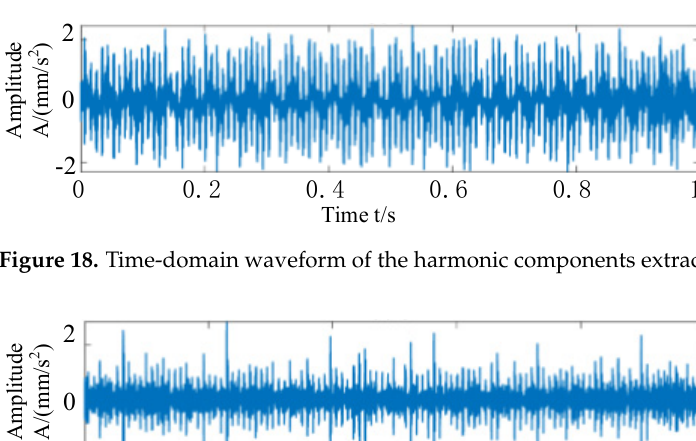
Figure 17. Sparse representation coefficients.